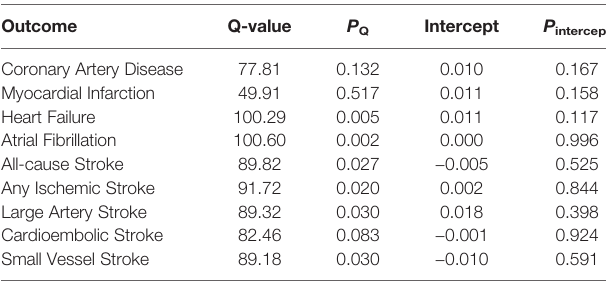
TABLE 3 | Heterogeneity and pleiotropy tests for the associations of multiple sclerosis with cardiovascular